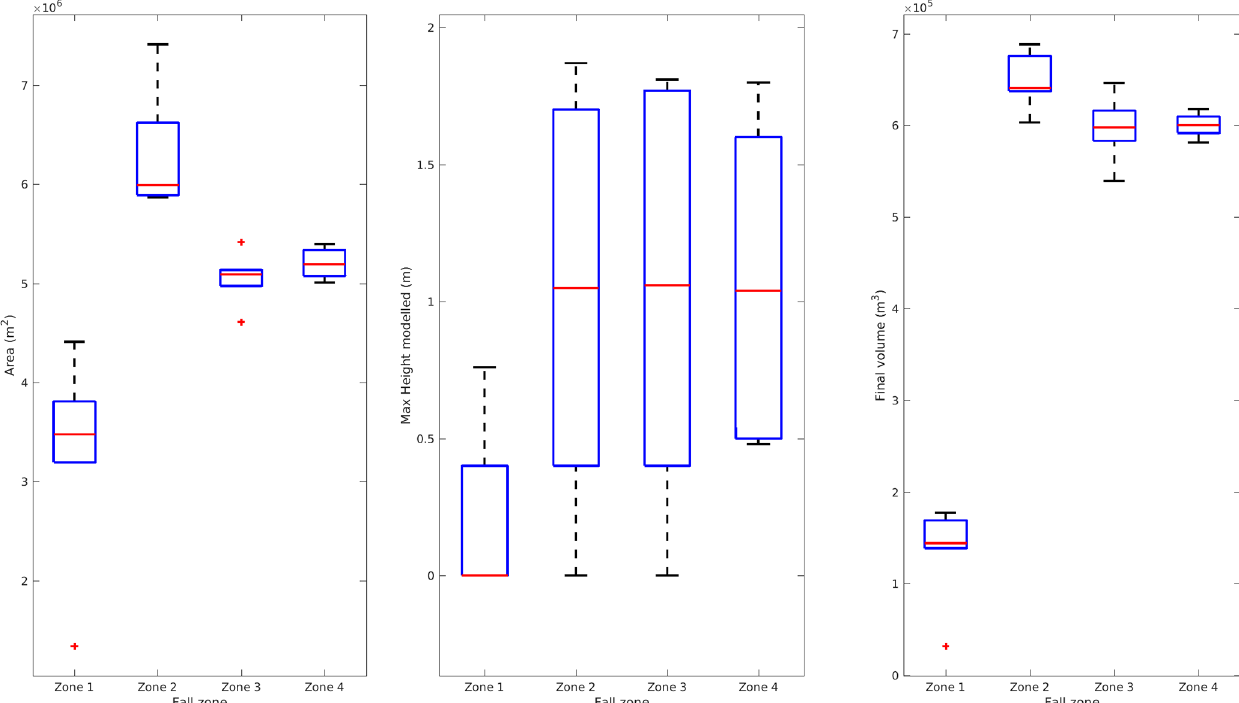
Figure 7. Impact of different debris